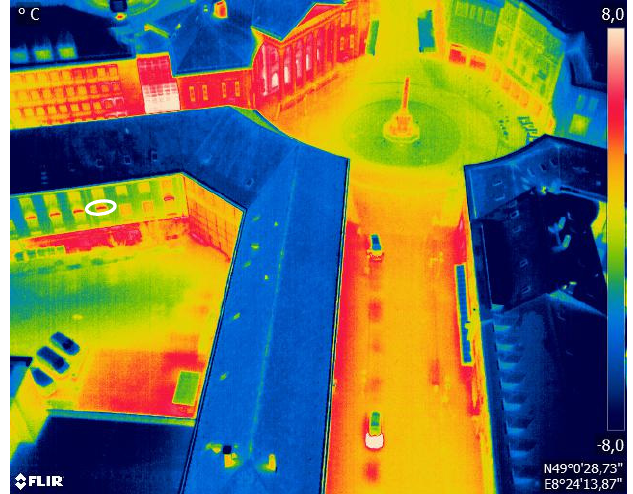
Figure A17. Example: thermal bridge of a roller shutter casing.